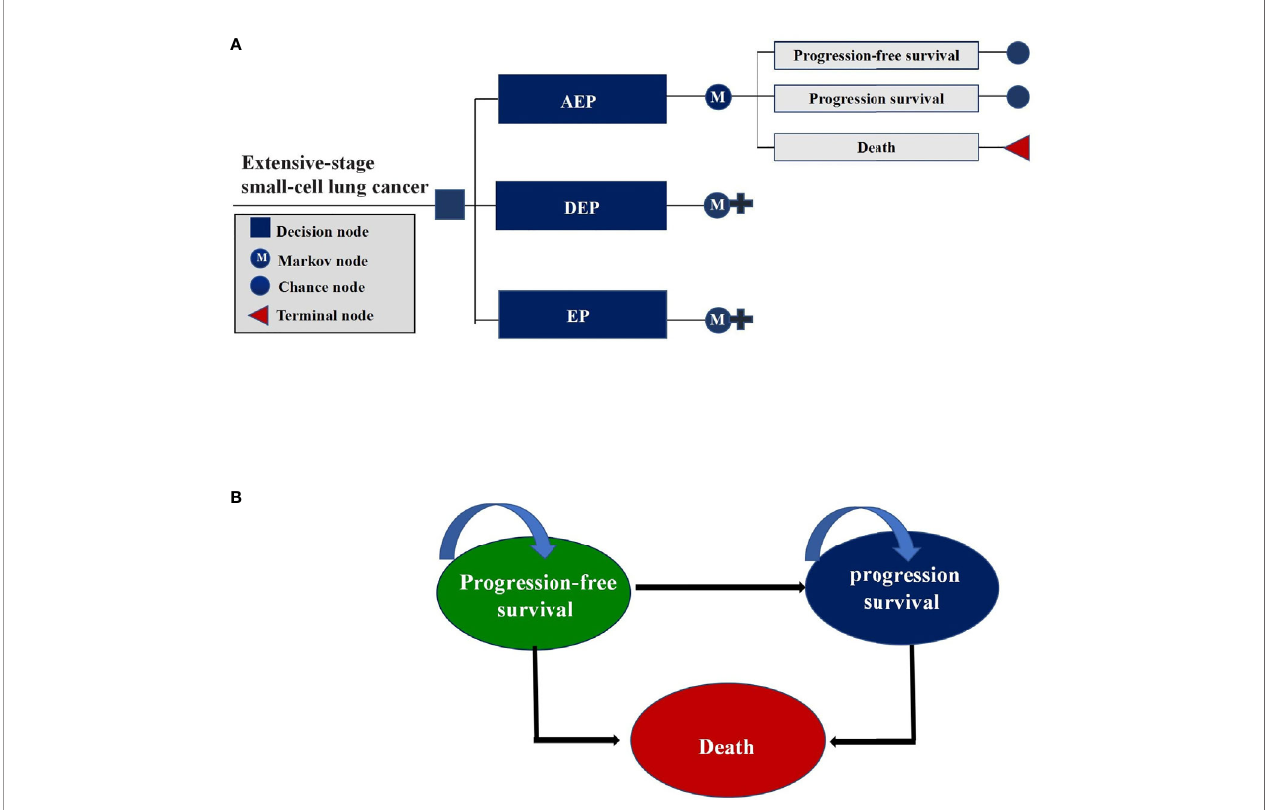
FIGURE 1 | Markov Model. (A) Schematics of the decision tree showing 3 treatment strategies compared in our model for patients with extensive-stage small-cell lung cancer; (B) Markov state transition model diagram showing 3 health states that represented the process of disease progression. M indicates Markov